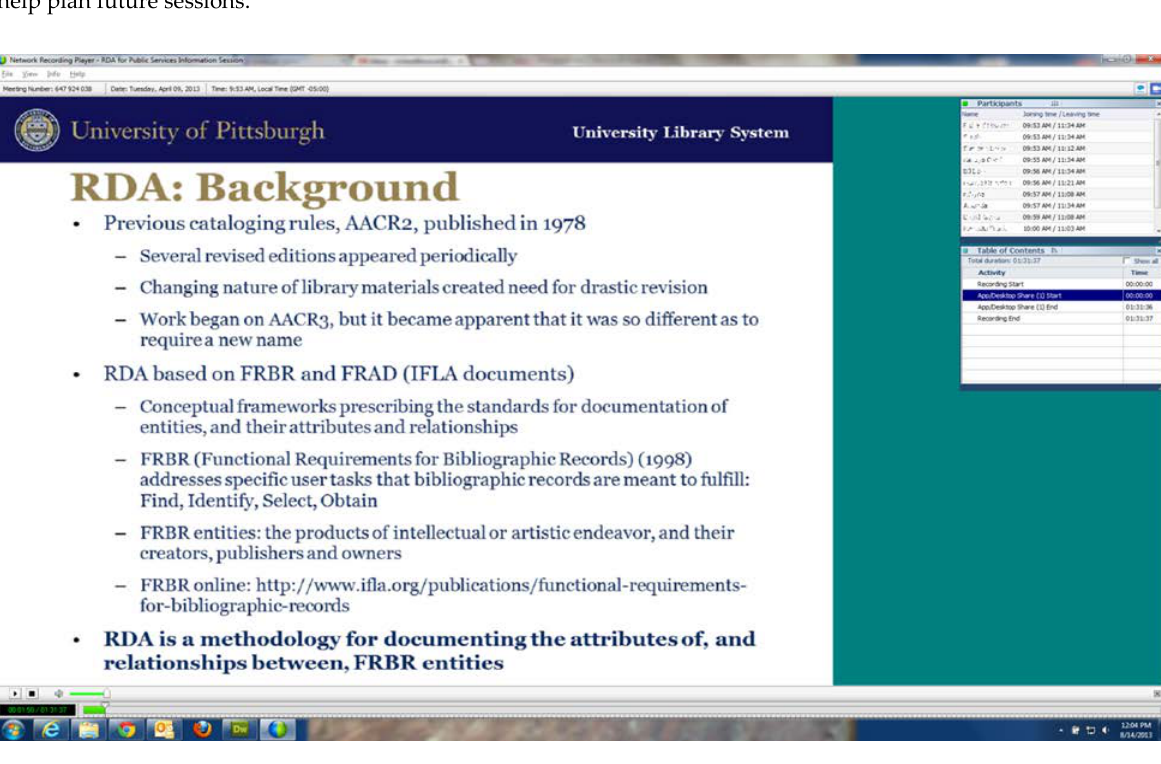
Remote participation for RDA staff training was enabled through the use of WebEx, a web-based, online conferencing